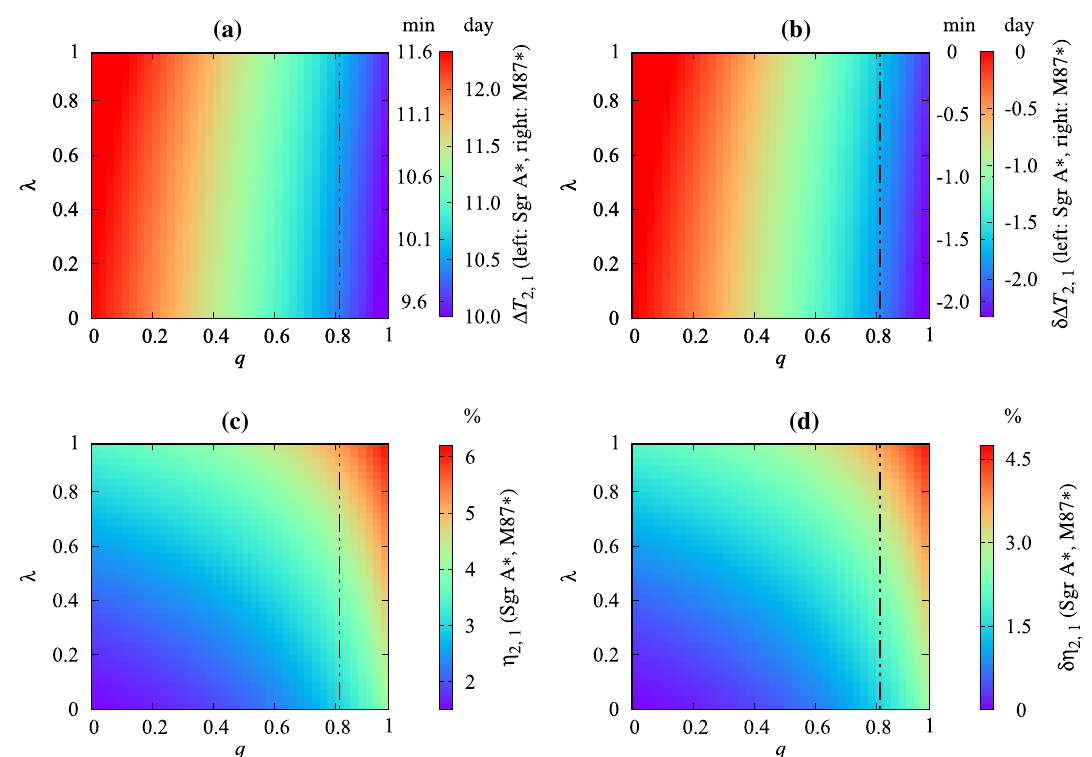
Fig. 9 Color-indexed Δ T 2 , 1 , δΔ T 2 , 1 , η 2 , 1 and δη 2 , 1 in the strong deflection gravitational lensing are shown for Sgr A* and M87* on D H (8). The dash-dotted lines mark the upper bound on q based on the shadow of M87* observed by EHT